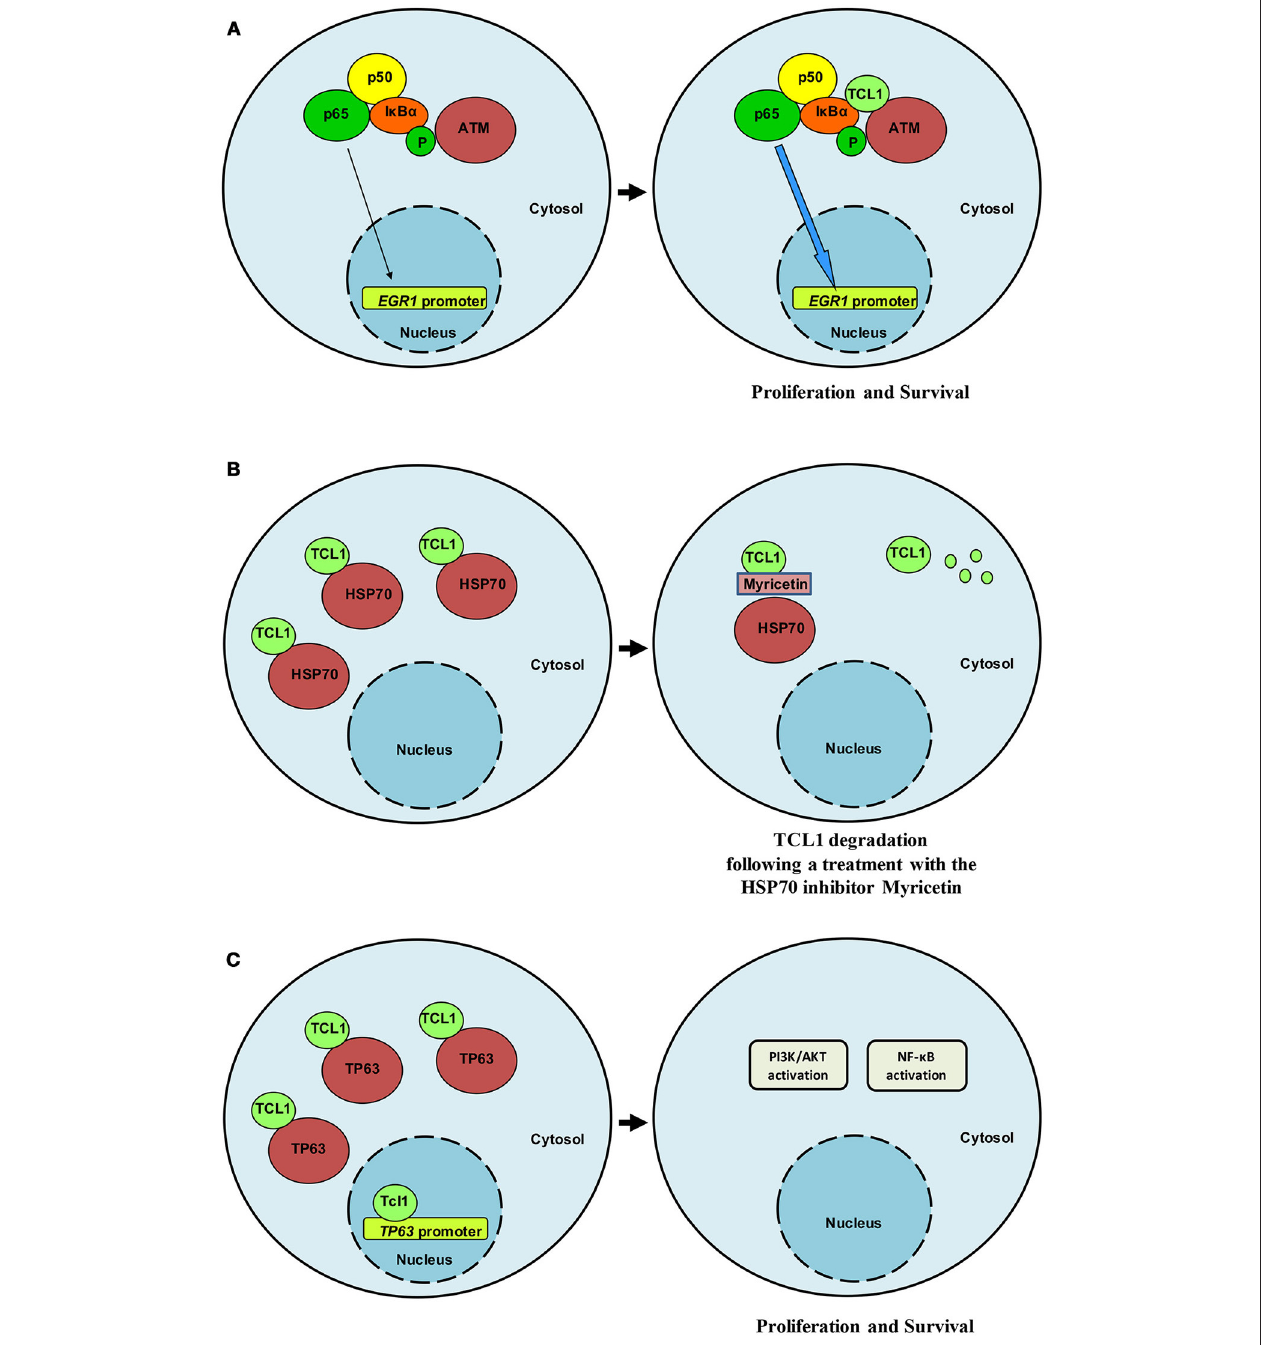
FIGURE 1 | TCL1 interacts relevant partners. (A) TCL1 interacts with ATM and I κ B and induces enhanced activation of the NF- κ B signaling pathway in CLL and lymphoma. (B) HSP70 regulates TCL1 protein folding and stabilizes its expression. Following treatment with myricetin, HSP70 activity is compromised and TCL1 is ubiquitinated and degraded. (C) TCL1 interacts with the transcription factor p63 and with its promoter region by recognizing an AP1 consensus sequence. TCL1 and p63 cooperate to activate both the PI3K and the NF- κ B signaling pathways. experiments demonstrated a direct role of TCL1 in the components of the AP1 complex. TCL1 modulates the down-regulation of PTPROt promoter activity along with promoter of the tumor suppressor PTPROt and, consequently, AP1 elements c-FOS and c-JUN (27), further validating the activity of BCR pathway, negatively regulated by the connection between TCL1 and transcription factors